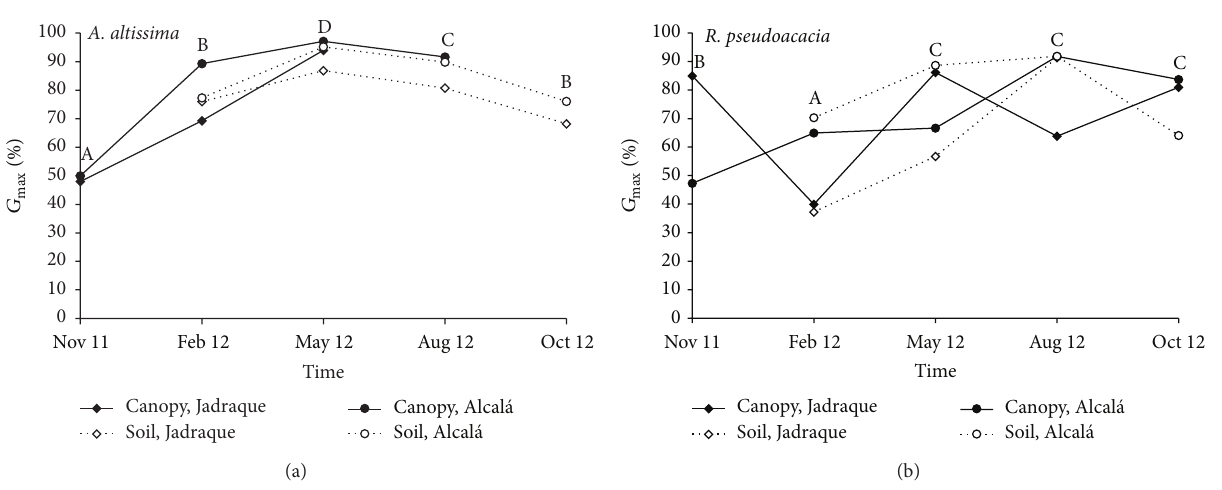
Figure 2: Maximum proportion of germinated seeds ( 𝐺 ) from the canopy and soil seed banks of Ailanthus altissima and Robinia max pseudoacacia from two populations (Jadraque and Alcal´a) throughout a year ( 𝑁 = 150 ). Uppercase letters represent significant differences among seeds of different age (i.e., at different moments of the ( 𝑃 < 0.05 ) in 𝐺 max